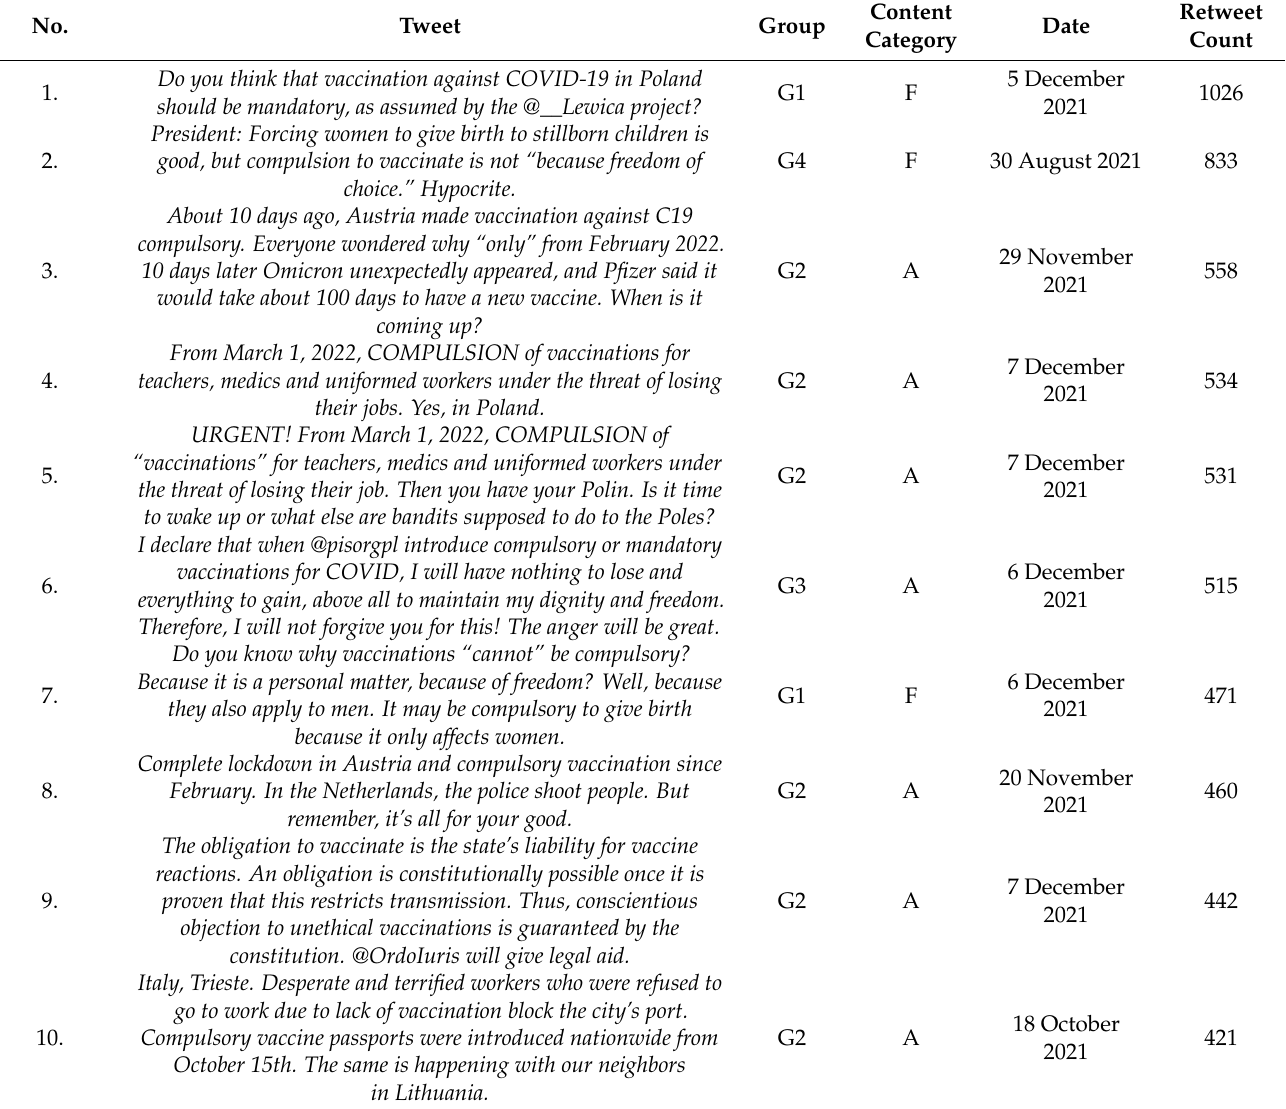
Table 5. Sentiment analysis of top 10 retweeted posts in the analysed period. Classification categories: F, in favour of mandatory vaccinations; A, against mandatory vaccinations.